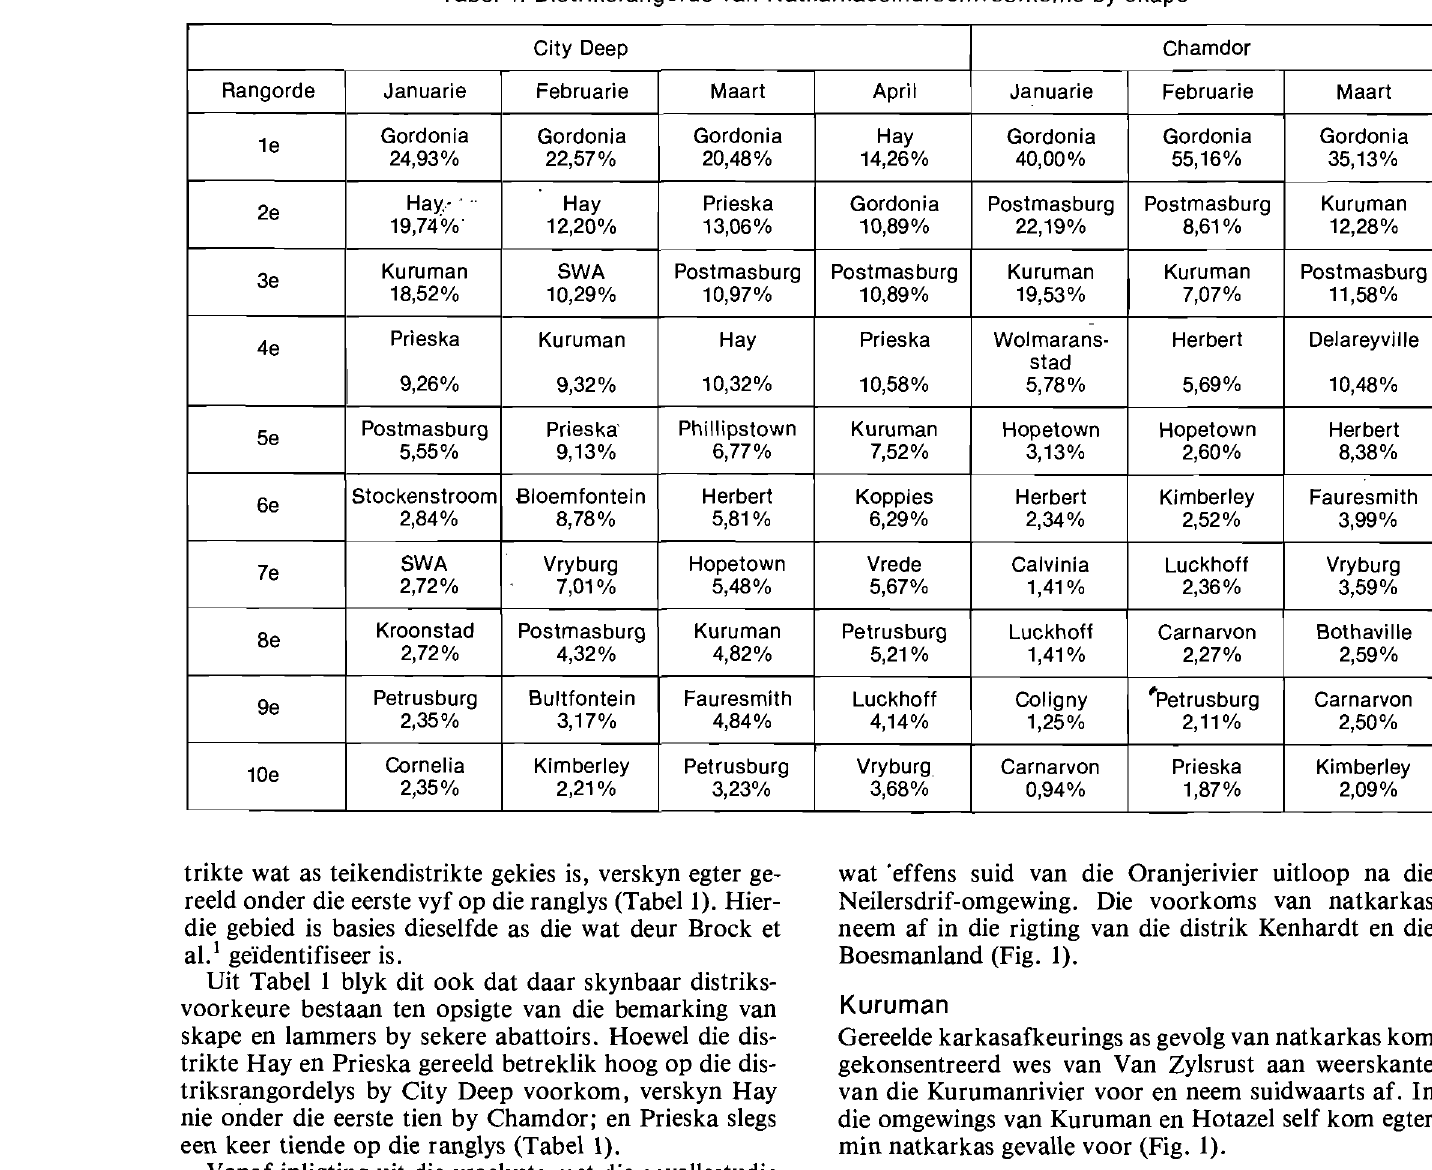
V olgens Fig. 1 word in hierdie distrik ook twee gekon sentreerde voorkomsareas aangetref. Albei Ie wes van die Langeberge by Olifantshoek, een in die omgewing van Mally wat suidwaarts geleidelik afneem en oorgaan in die tweede gebied wat ongeveer vanaf Lombaards vlakte tot by Pearsons Hunt en Koeipan strek. In die omgewing van Danielskuil word relatief min gevalle ge rapporteer.